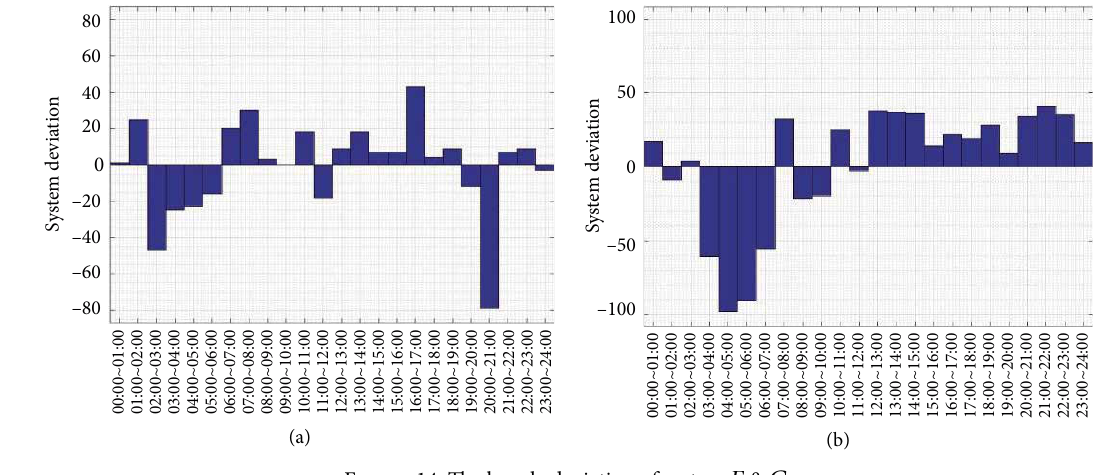
Figure 14: The hourly deviation of system 𝐸 & 𝐺